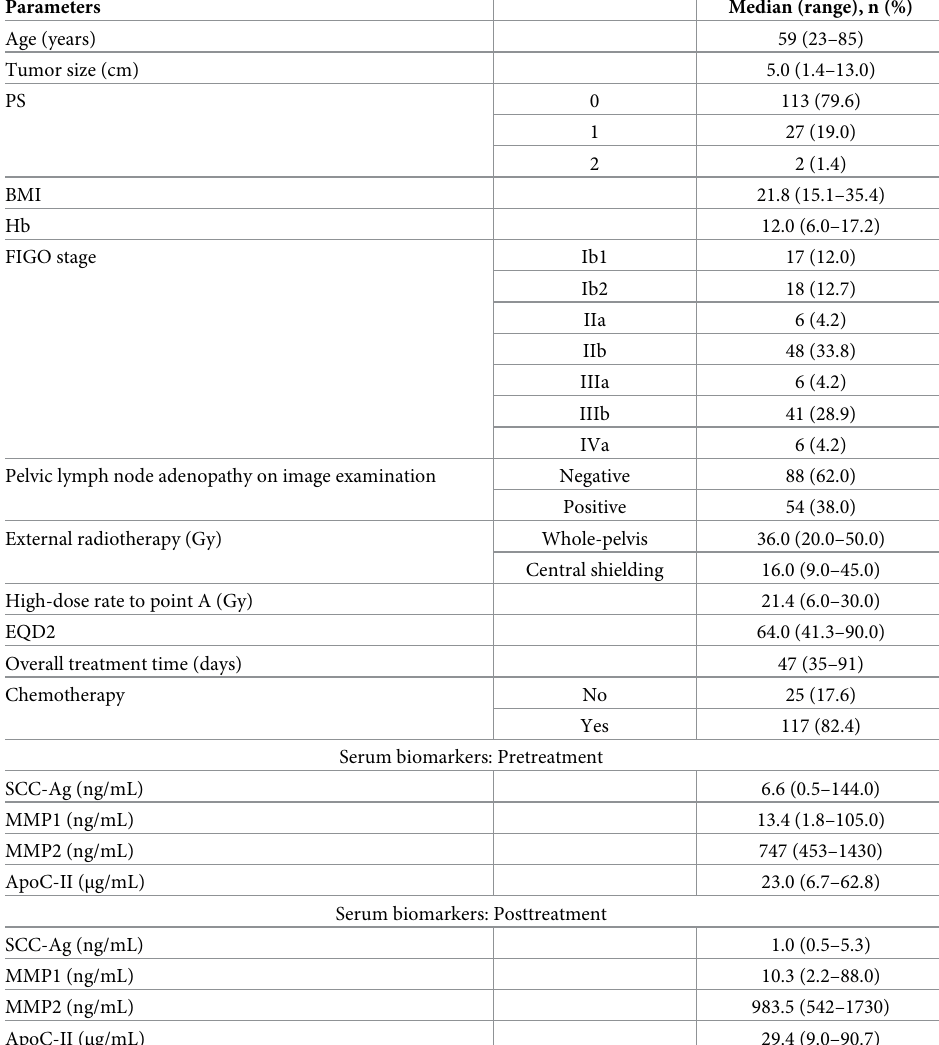
Table 1. Patient characteristics (n = 145) and clinical information. Parameters